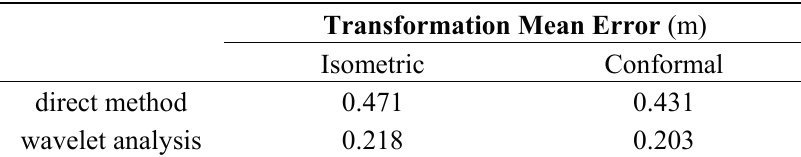
Table 1. Accuracy of